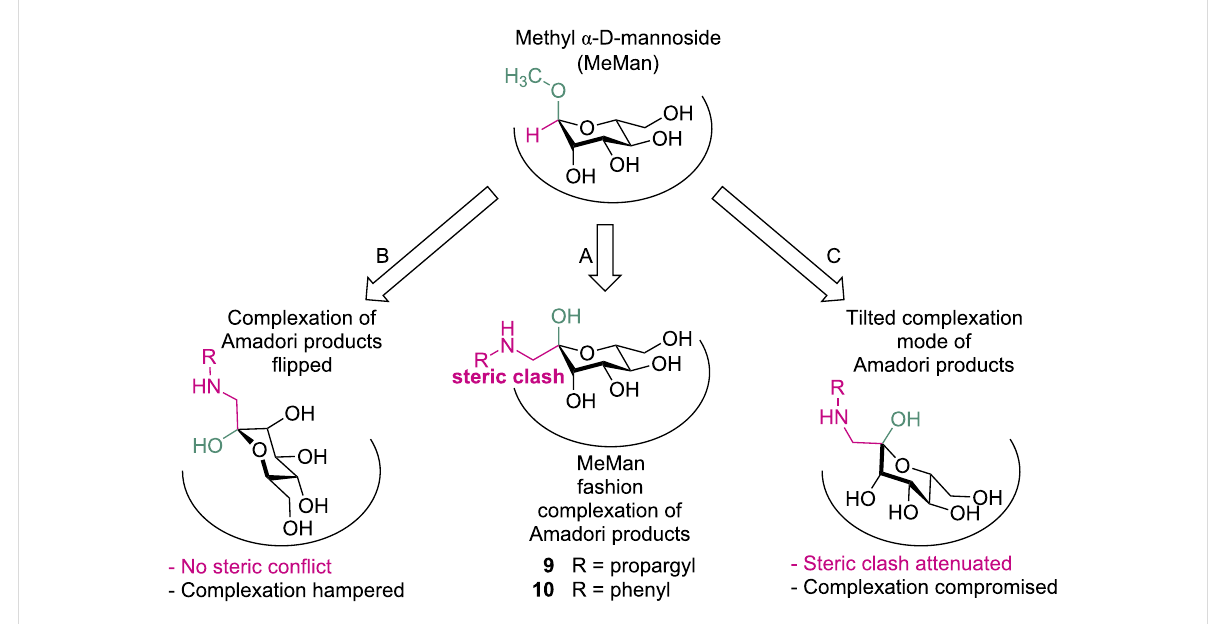
Figure 2: Cartoon illustrating ligand binding by the bacterial lectin FimH. Complexation of D- manno -configured C -glycosyl-type glycoconjugates inside the carbohydrate recognition domain (CRD) of FimH in analogy to MeMan ( 1 , top) is hampered by the bulky C -glycosidic substituents in β -position, resulting in a steric clash (A). Rotation of the Amadori product averts steric conflict, yet causing insufficient complexation inside the binding pocket (B). Compromised complexation and attenuation of steric conflict may be achieved by a tilted orientation of the mannoside within the FimH carbohydrate binding site